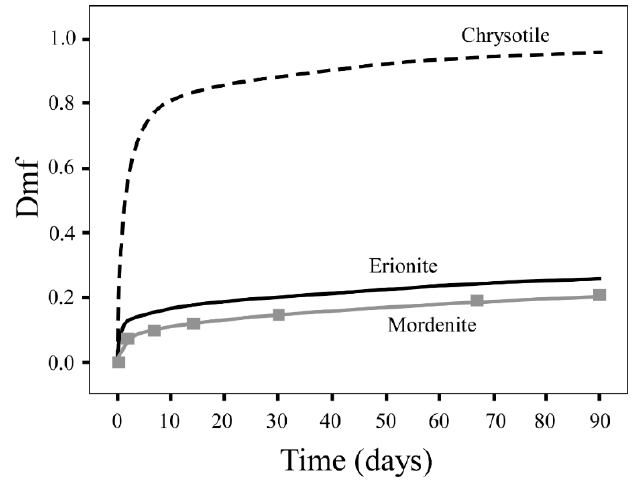
Figure 5. The raw dissolution curves of Poona mordenite. Trend of raw dissolution curves of chrysotile and fibrous erionite were reported for comparison [62].